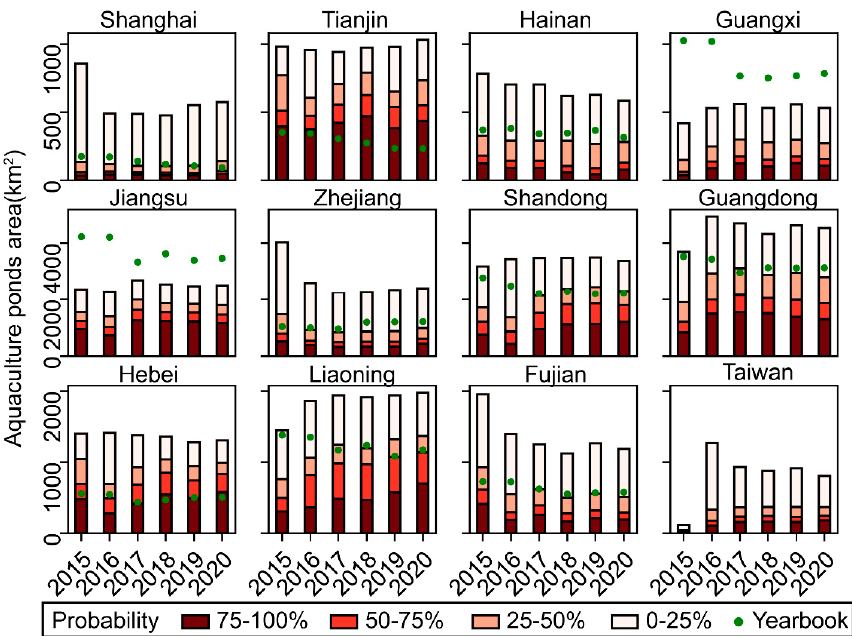
Figure 7. Histogram of cumulative area of aquaculture pond probability within a 50 km buffer zone in 12 coastal provinces in China from 2015 to 2020.